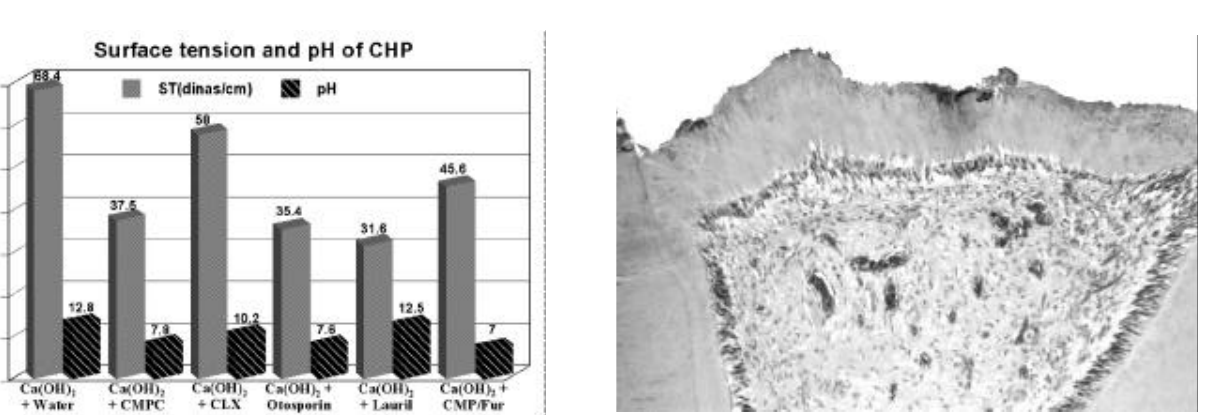
FIGURE 2- Calcium hydroxide 7 days. Complete closure of the main root canal by neoformed cementum (H.E. X100) (Holland et al . 62 ).